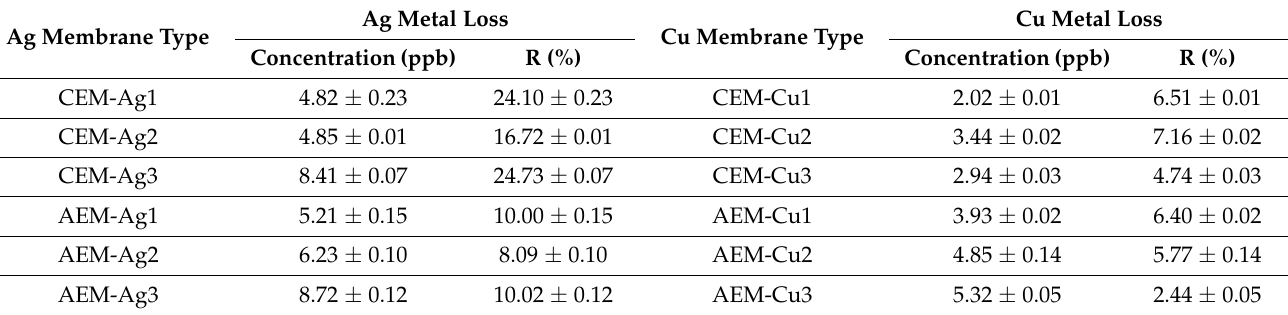
Table 6. Metal leaching of Ag- and Cu-functionalized UF heterogeneous IEMs under filtration using dead-end filtration